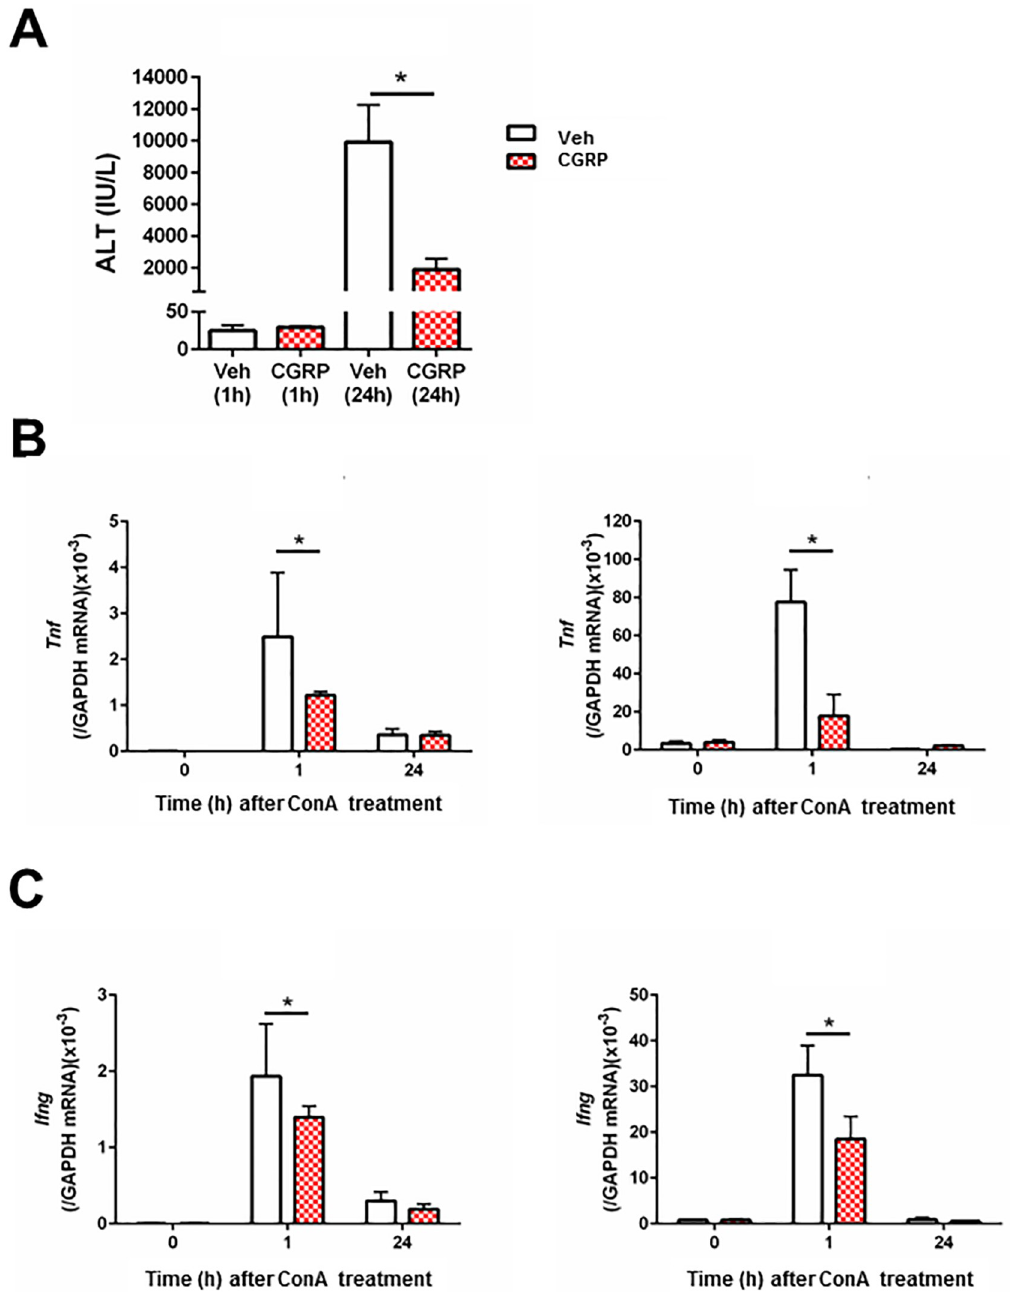
Fig 7. Effects of CGRP treatment on ALT and pro-inflammatory cytokine levels during ConA hepatitis. CGRP or vehicle was administered 30 min before ConA treatment. (A) ALT levels in WT mice treated with CGRP at 1 h and 24 h after ConA administration. Veh, vehicle. Data are expressed as the mean ± SD from 4–6 mice per group. � p < 0.05. (B) Amount of Tnf mRNA in the liver and spleen after ConA administration. Data are expressed as the mean ± SD from 4–6 mice per group. � p < 0.05. (C) Amount of Ifng mRNA in liver and spleen after ConA administration. Data are expressed as the mean ± SD from 4–6 mice per group. � p <